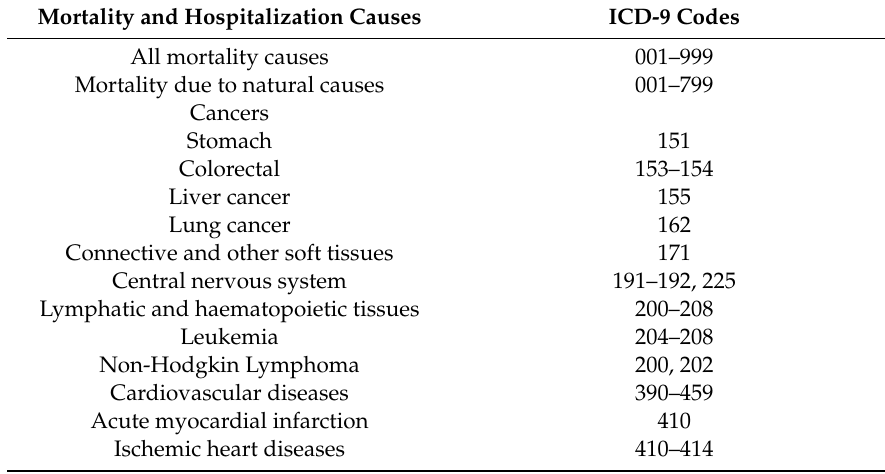
Table A1. Mortality and hospitalization causes considered in the present study-International Classification of Diseases, 9th Revision (ICD-IX) associated